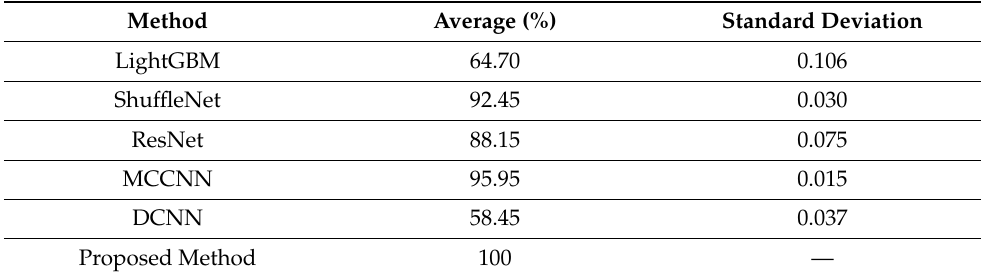
Figure 16. Comparisons between the different fault diagnosis methods. Table 6. Average accuracy and SD of the different methods.